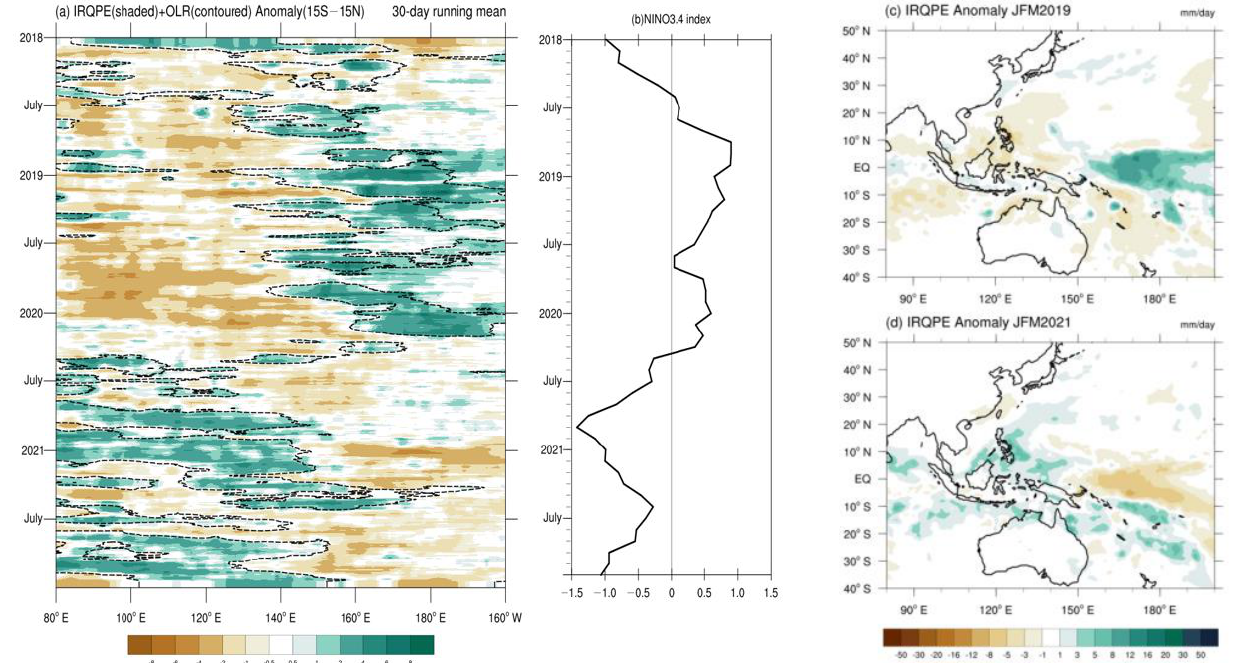
Figure 5. IRQPE application for ENSO. ( a ) Time-longitude cross sections of IRQPE anomaly (colored, unit: mm/day) and OLR anomaly (dash contoured, only for negative value below − 5 W/m 2 ) over 15° S – 15° N ( b ) Monthly NINO3.4 ENSO index. ( c , d ) Seasonal anomaly of IRQPE for late extended boreal winter season (January~March) in 2019 and 2021, respectively.